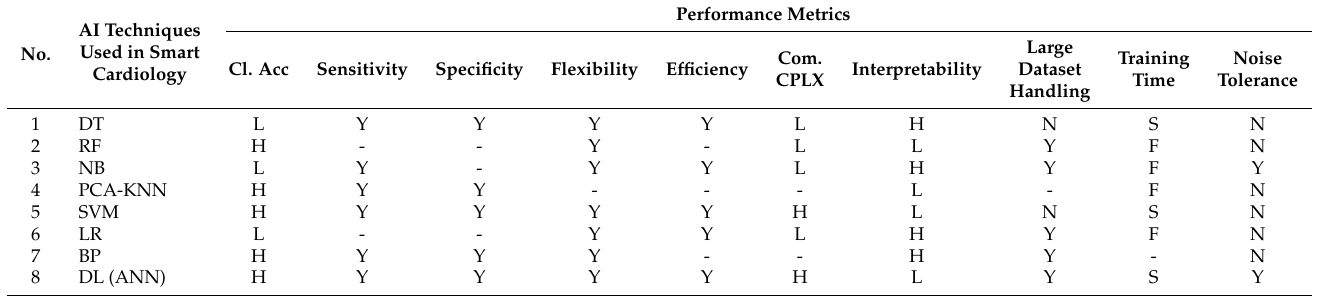
Table 13. Comparative analysis of various AI techniques used for prognosis/diagnosis of CVDs.